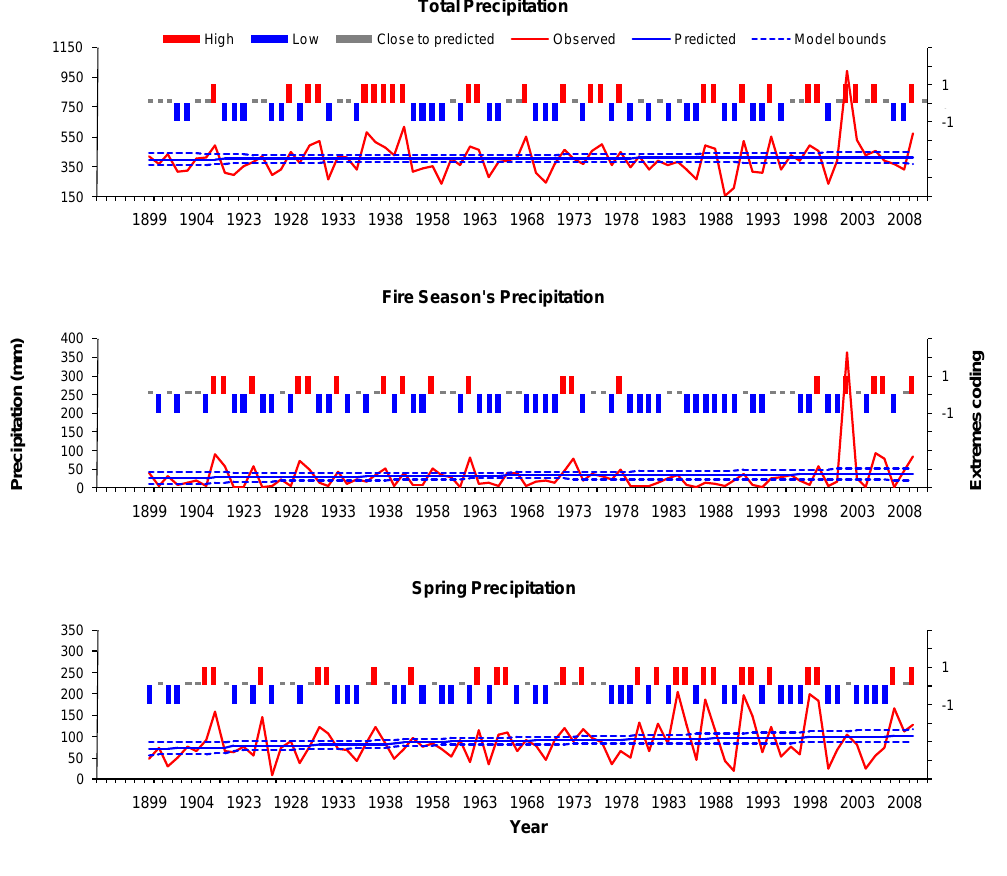
Fig. 5. Trend lines and the 95% confidence intervals of the model around the trend line of precipitation-related meteorological parameters (total, spring and fire season precipitation). These are used as bounds to define strongly positive (red columns), strongly negative (blue columns) and close-to-predicted (grey columns) values of fire